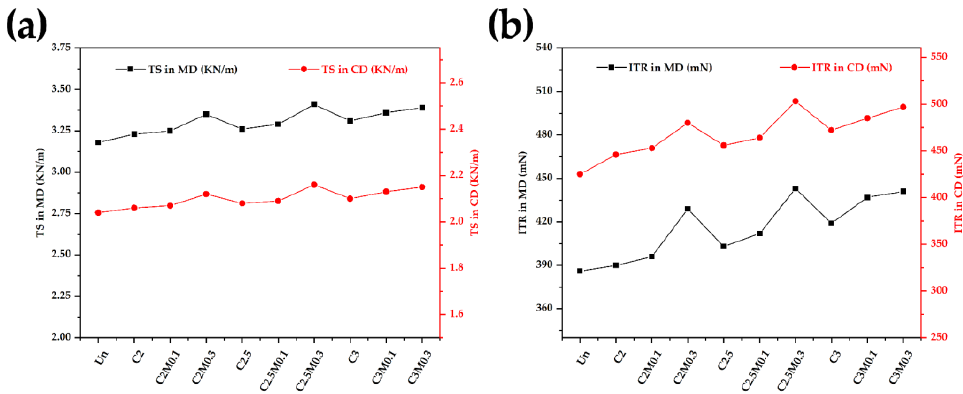
Figure 6. The TS ( a ) and ITR ( b ) of the uncoated paper and coated papers in the machine direction (MD) and cross direction (CD).